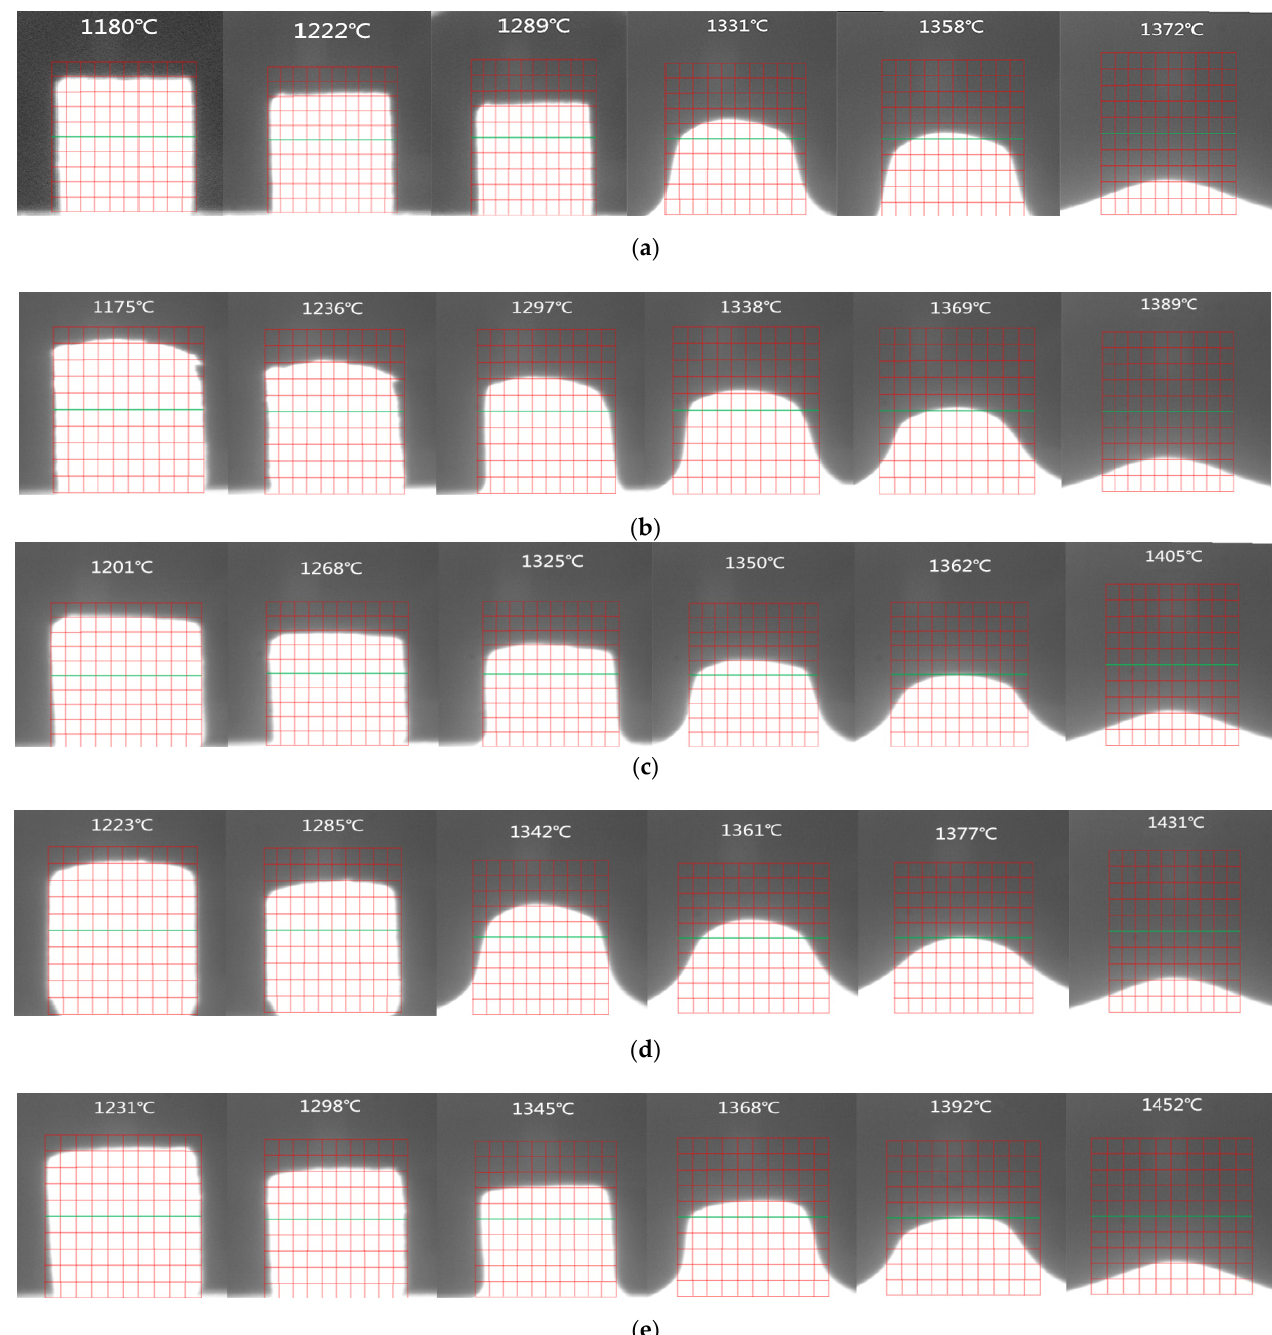
Figure 4. Melting process for samples with different basicity values. ( a ) R = 2.1; ( b ) R = 2.0; ( c ) R = 1.9; ( d ) R = 1.8; ( e ) R = 1.7.